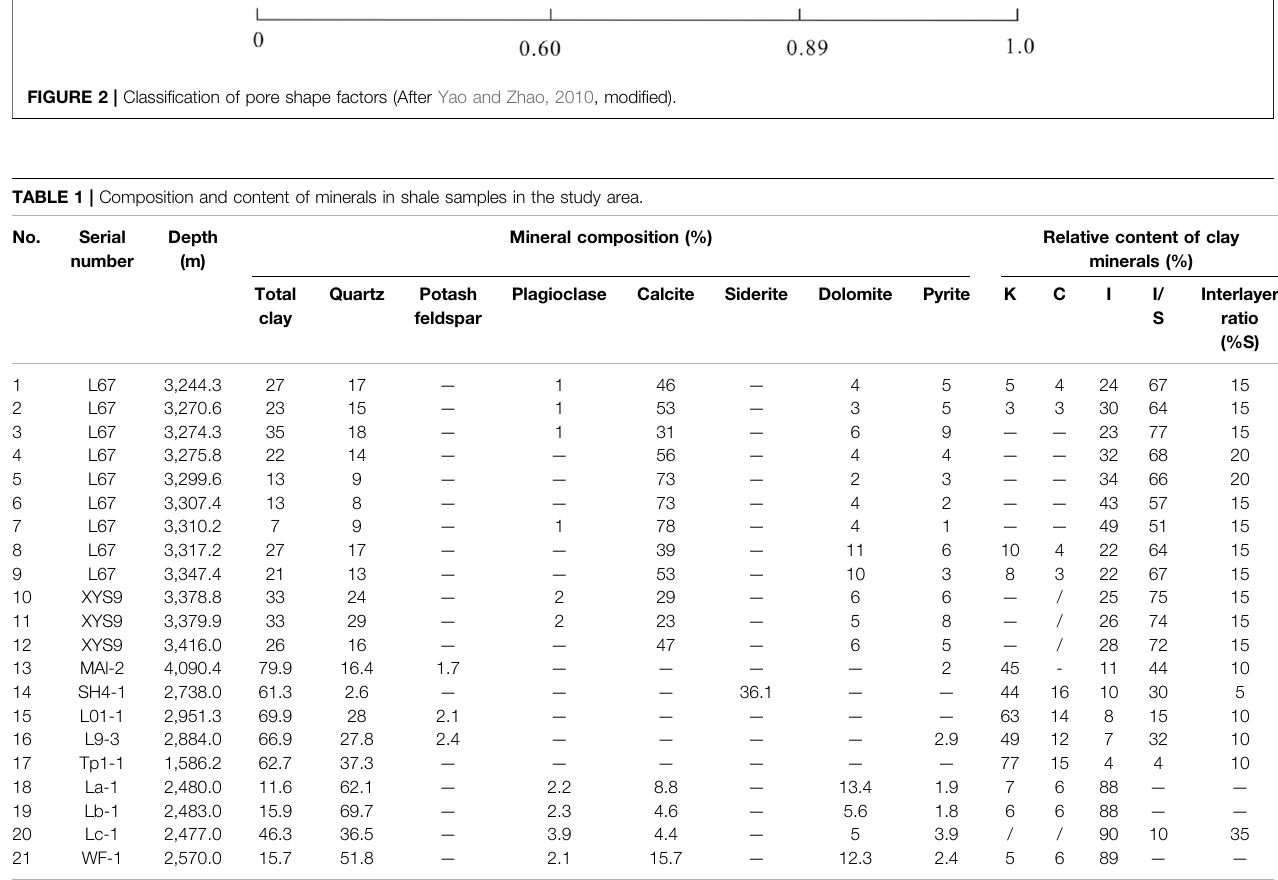
FIGURE 2 | Classi fi cation of pore shape factors (After Yao and Zhao, 2010, modi fi ed).